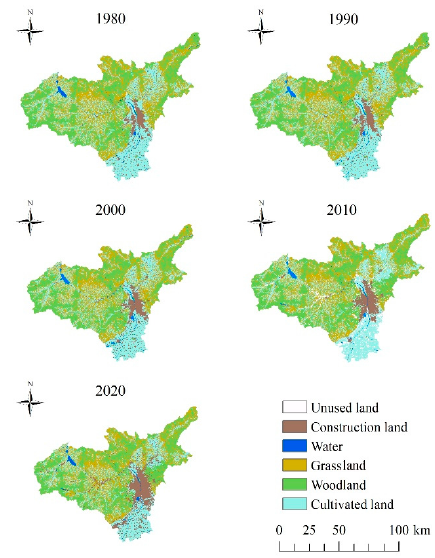
Figure 3. Land use change from 1980 to 2020 in Taiyuan City.